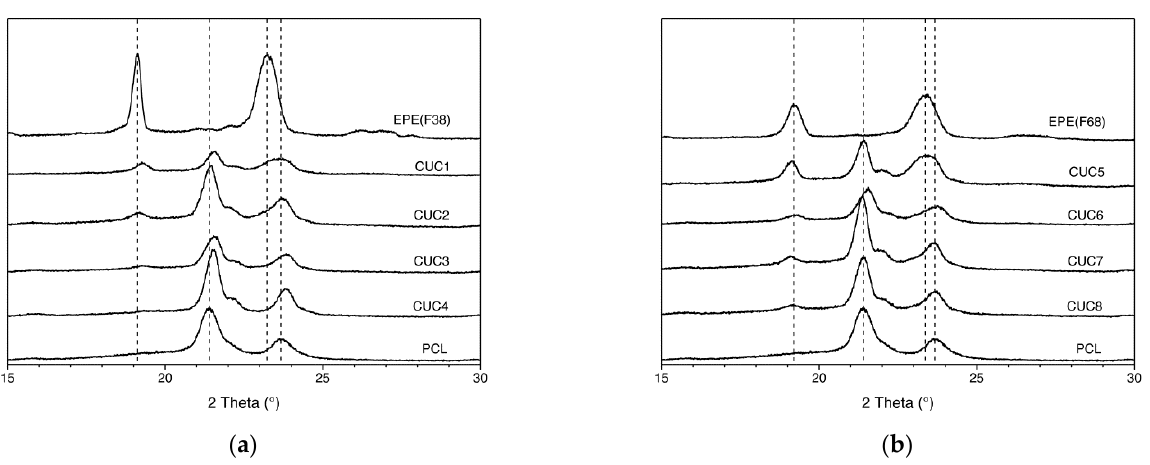
Figure 6. WAXD patterns of CUC copolymers compared with respective macro-initiator EPE and PCL. ( a ) CUC1–CUC4 and ( b ) CUC5–CUC8 series.